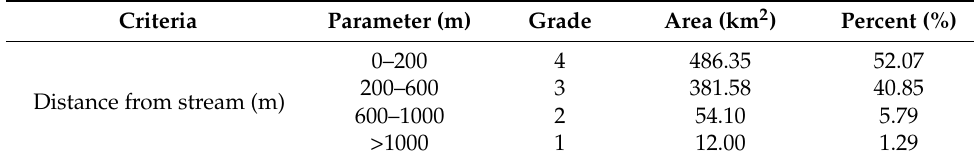
Table 10. Assessment of hydrological conditions.